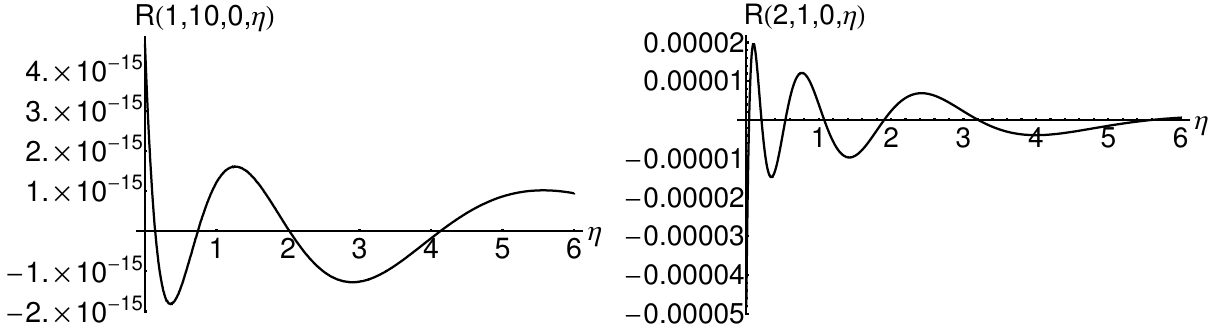
Figure 13: The residual R (1, 10, 0, η ) for Eq. (49) obtained by OAFM